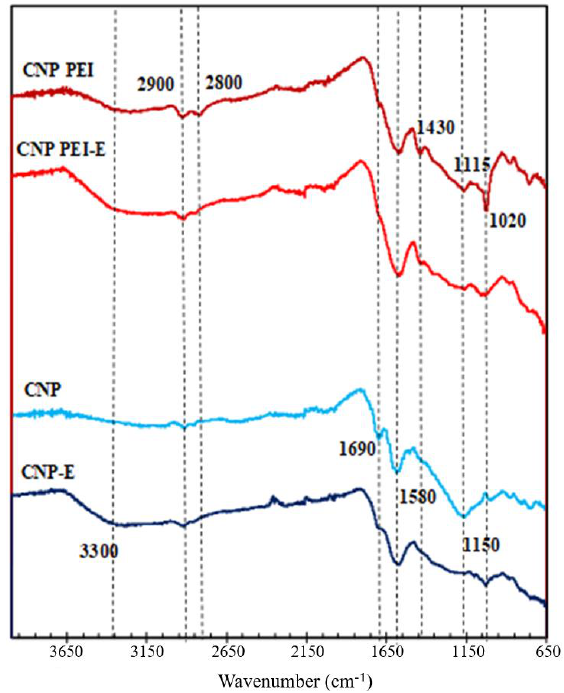
Figure 3. FTIR spectra of CNP and CNP PEI and their exhausted counterparts.